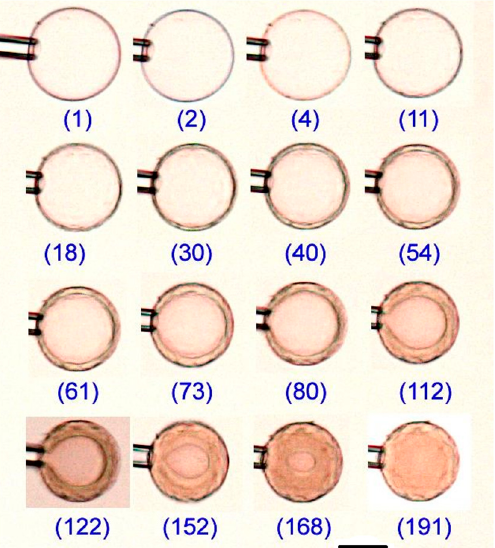
Figure 3. Microscopy images of microgel B at different times during deswelling in 800 mg/L lysozyme solutions (NaCl/tris buffer; pH 8.0, I = 10 mM). Numbers indicate the time in minutes after exposure to the protein solution. The tip of the micropipette is seen to the left of the microgels. Scale bar = 50 µm.